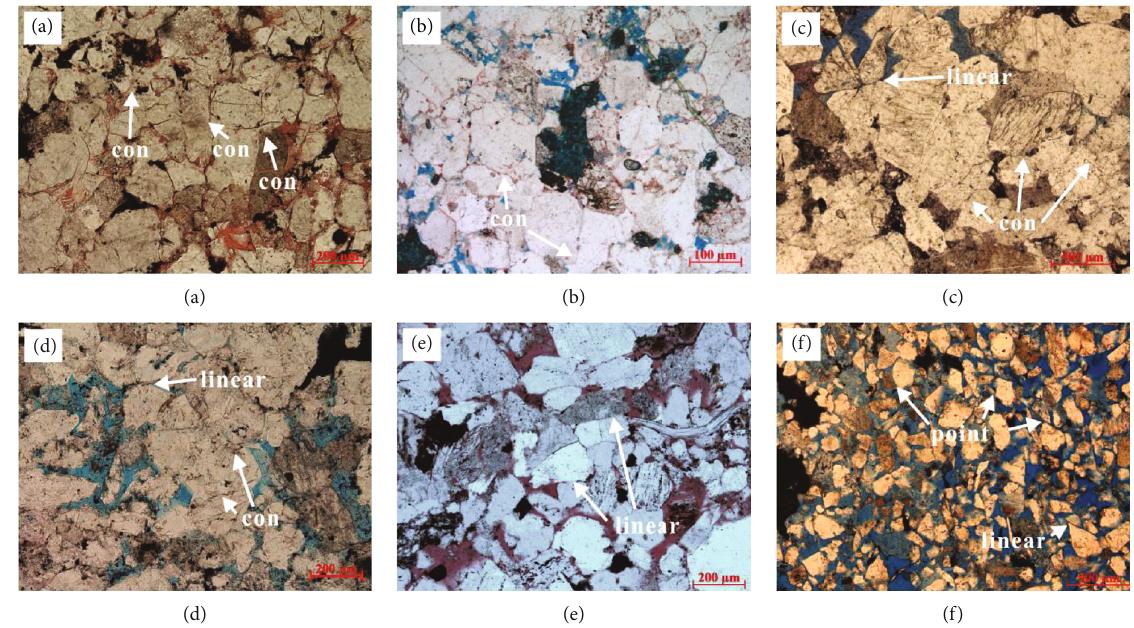
Figure 4: Microscopic characteristics of sandstone compaction in Zhuhai Formation: (a) contact between detrital minerals in sandstones is mainly concavo-convex (con), Y33-1, Gra = 35 : 6 ° C/km ; (b) contact between detrital minerals in sandstones is mainly concavo-convex (con), Y35-2, Gra = 39 : 3 ° C/km ; (c) contact between detrital minerals is mainly linear and concavo-convex (con), W3-2, Gra = 47 : 2 ° C/km ; (d) contact between detrital minerals is mainly linear and concavo-convex (con), H34-6, Gra = 48 : 0 ° C/km ; (e) contact between detrital minerals is mainly linear, W3-1, Gra = 53 : 0 ° C/km ; (f) contact between detrital minerals is mainly point and linear, W21-1, Gra = 66 : 4 ° C/ km . Table 1: The original porosity (OP) and porosity loss by compaction (COPL) of sandstones in the Zhuhai Formation. Region